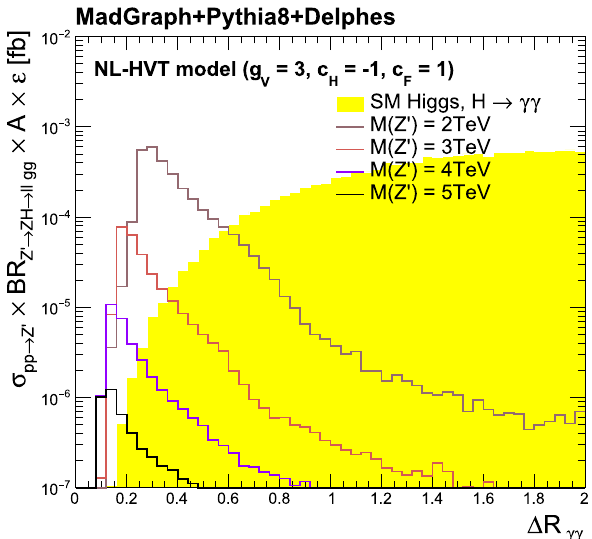
Fig. 6 Z (cid:2) → Z H → (cid:10)(cid:10)γγ Higgs yields with respect to Δ R γγ , dN / d Δ R γγ , in fb, as predicted from the non-local form factor in Eq. 3 with a = 1. The expected SM Higgs yield for the same selection is overlayed in